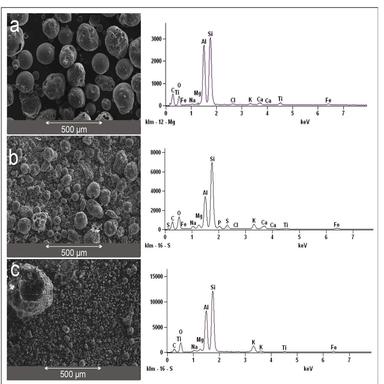
Typical SEM images of a) FA_Cen b) FA_PP c) FA_Mix ash samples with the corresponding EDS analysis.